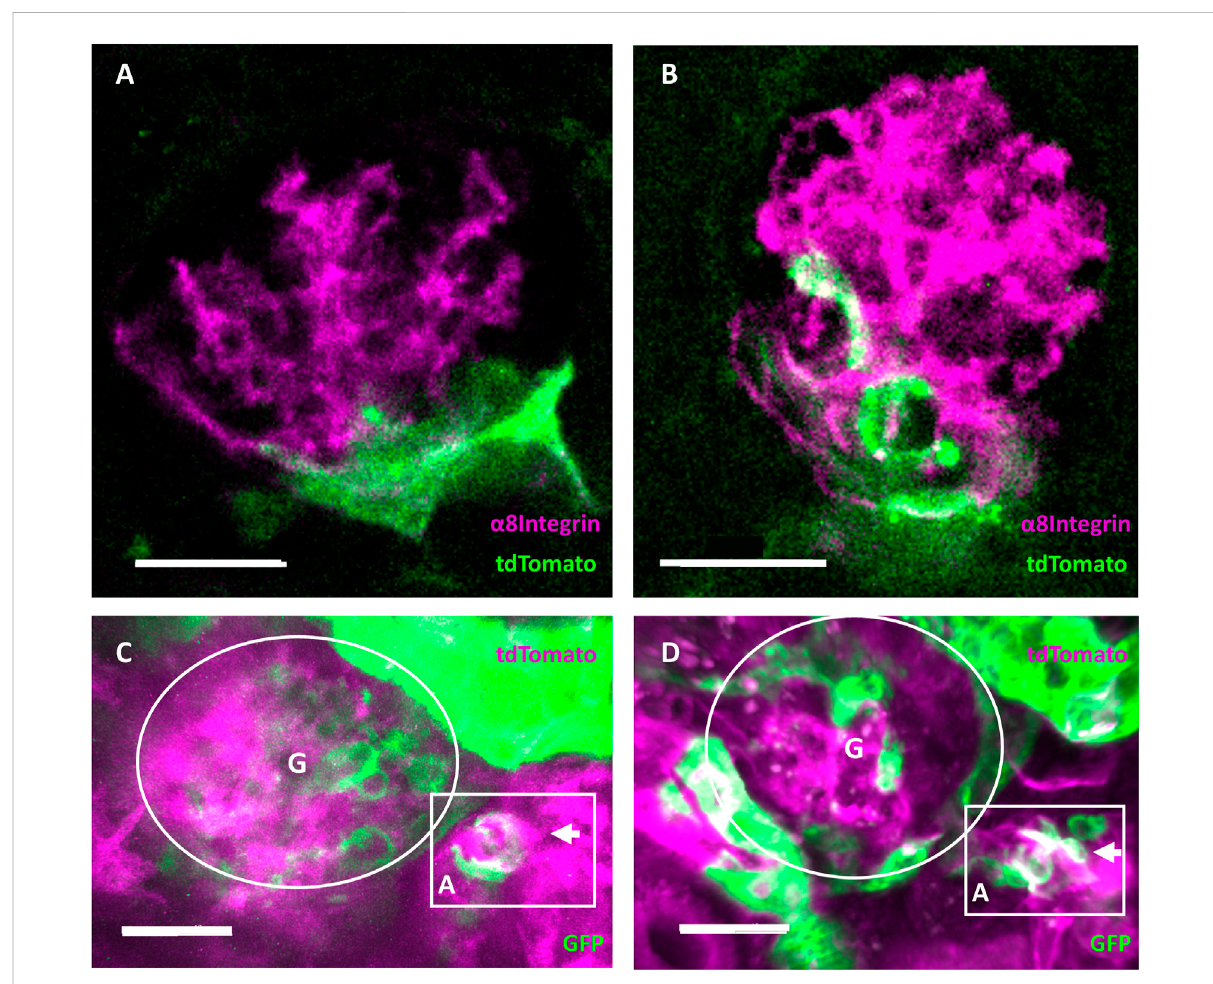
FIGURE 7 Evidence of regeneration and neogenesis during renin cell migration. (A) Healthy and (B) injured glomeruli from cleared mouse kidneys after intravital experiment endpoints. Complementary pseudocolors mark tdTomato immunohistological staining in green and α 8Integrin in magenta. White areasindicate overlap inproteinexpression.The overlap of α 8Integrin withtdTomatopositive renin cell descendants after migrationin injured glomeruli quanti fi ed to a mean of 32.71 ± 15.56% ( n = 7). (C) RC neogenesis over (D) 6 days following renin cell migration in individually injured mRen-Cre-mT/mG mouse glomeruli demonstrated by single cell switch (arrows) from membrane-tdTomato-expressing non-RC (magenta) to membrane-GFP-expressing RC (green). Gradient tdTomato and GFP double positive signals are visible in white (magenta and green, respectively). Rectangular box highlights the neogenesis located at the JGA in three-dimensional intravital imaging data around the afferent arteriole (A) of one identical glomerulus (G) . Acluster of denovo differentiated RC(whiteand green cells intherectangular box atd6)can beseen inthearteriole. White scale bars represent 20